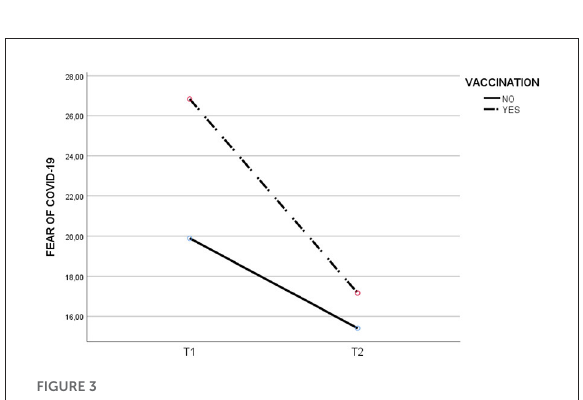
FIGURE3 Evolution of COVID-19 fear at T0, T1 and T2 for vaccinated and